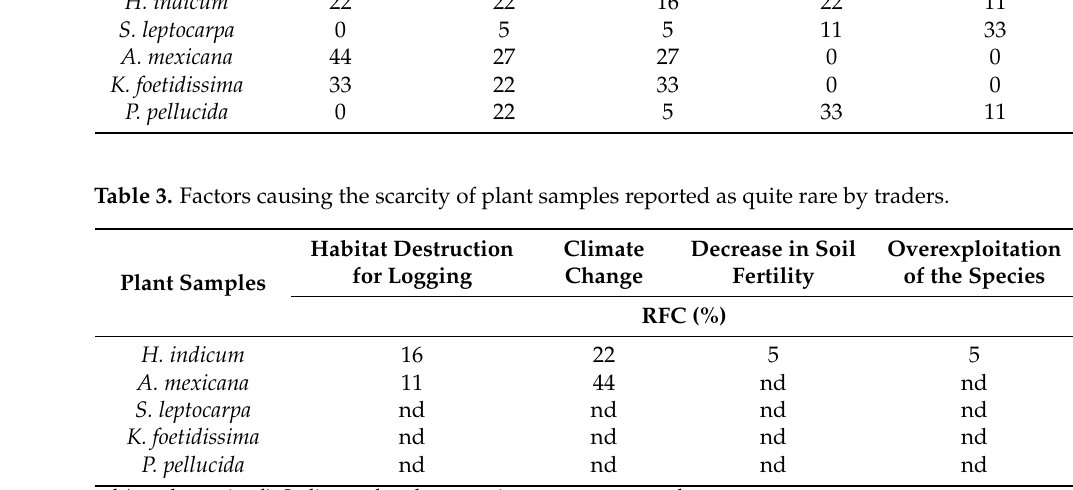
Table 2. Ranking of the study species according to their traders. Plant